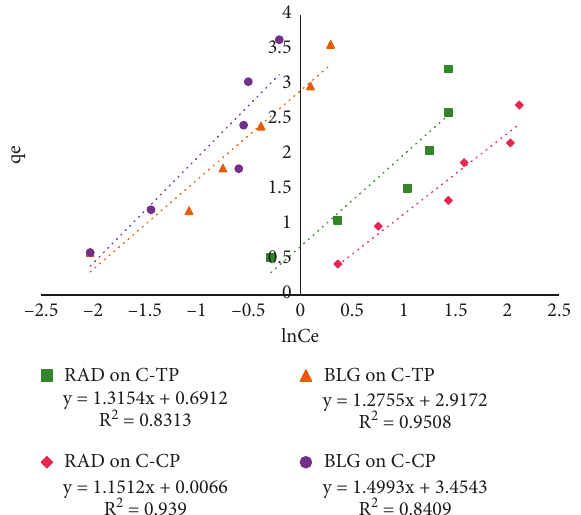
Figure 16: A comparison of the Temkin isothermal model for the adsorptive dye removal efficiency of acid-treated biosorbents. Initial pH � 5, final pH for RAD on C-TP and C-CP � 4, BLG on C- TP � 4.5, and BLG on C-CP � 4.